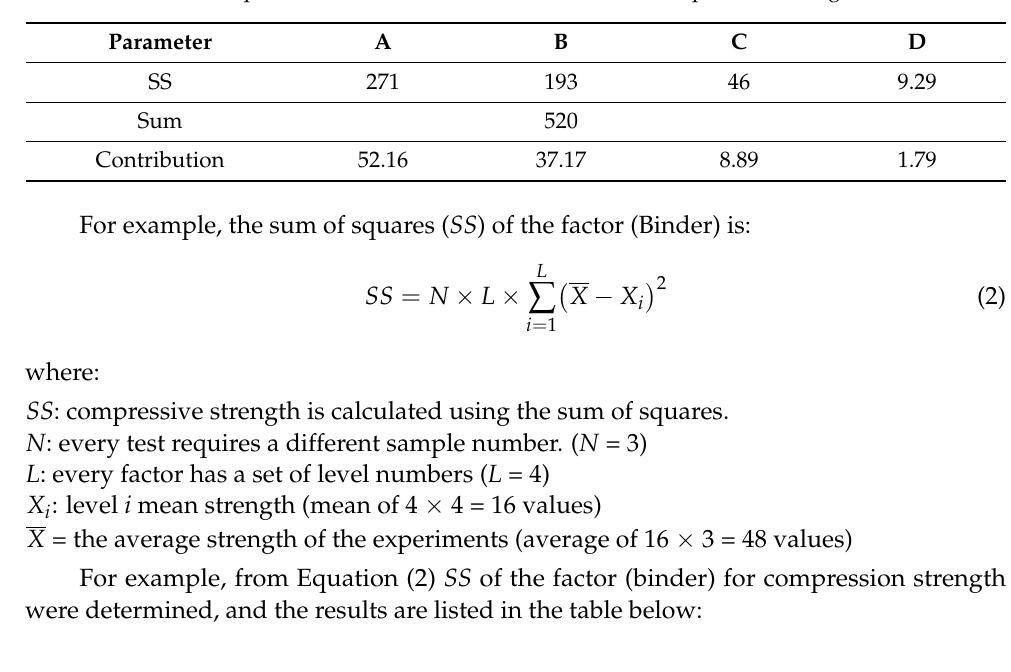
Figure 8. Influence of factors and level on compressive strength (MPa): ( a ) effect of molar content and binder, ( b ) effect of superplasticizer and Na 2 SiO 3 /NaOH ratio, ( c ) effect of molar content and superplasticizer, ( d ) effect of binder and Na 2 SiO 3 /NaOH ratio. Table 7. The sum of squares and contribution of each factor on compressive